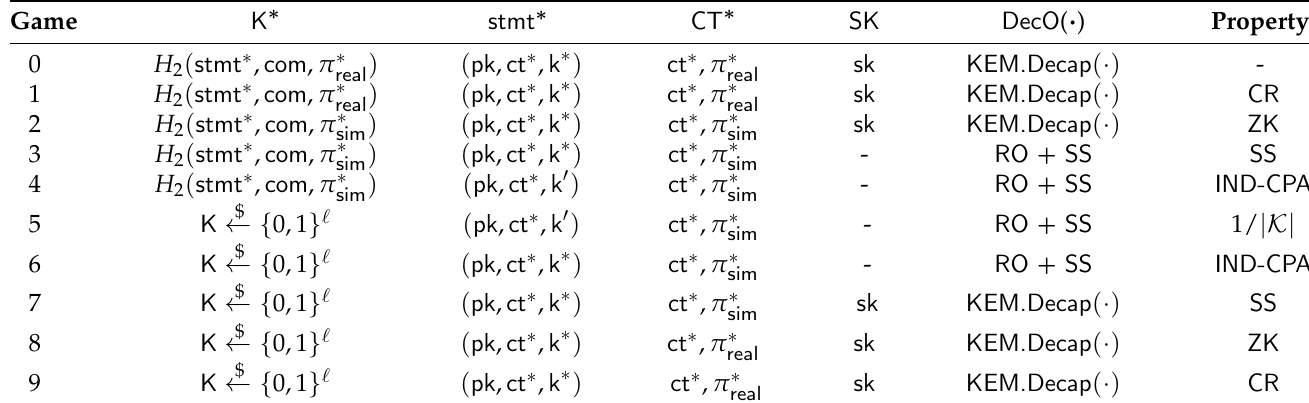
Table 1. Values or operations of K ∗ , CT ∗ , SK , and DecO ( · ) in each game and properties ensuring the indistinguishability of consecutive games. RO + SS denotes that the simulator retrieves k from a random oracle table and checks the validity of the ciphertext based on the SS